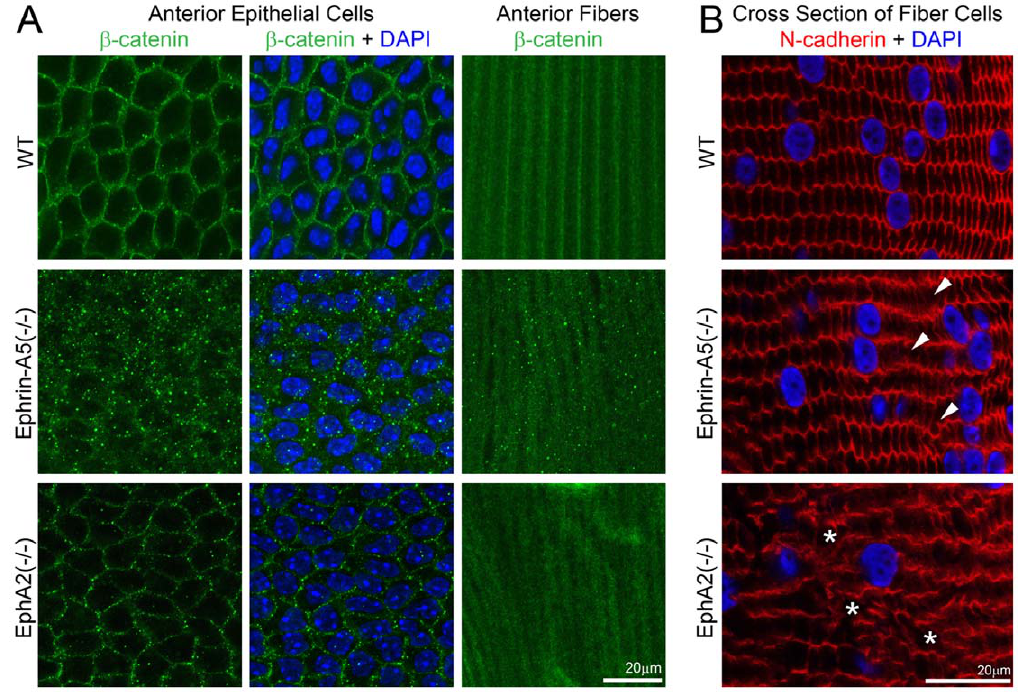
Figure 5. Beta-catenin distribution in anterior epithelial cells and underlying lens fibers and N-cadeherin localization in lens frozen sections. Immunostaining of lens capsule flat mounts shows cell membrane distribution of b -catenin proteins in both anterior epithelial cells and fiber cells of a P21 WT lens (A). Membrane association of b -catenin remains unchanged in EphA2(-/-) anterior lens epithelial cells, but b -catenin proteins form substantial small aggregates in both anterior epithelial cells and fiber cells of ephrin-A5(-/-) lenses (A). Scale bar, 20 m m. N-cadherin is localized at the cell boundaries of hexagonal shaped lens fibers in the WT lens section (B). In the ephrin-A5(-/-) lens section, the majority of fiber cells show normal localization of N-cadherin proteins except select abnormal fiber cells (B, arrowheads). In the EphA2(-/-) lens section, the distribution of N-cadherin proteins is severely altered with some areas lacking N-cadherin staining (B, asterisks). Scale bar, 20 m m.